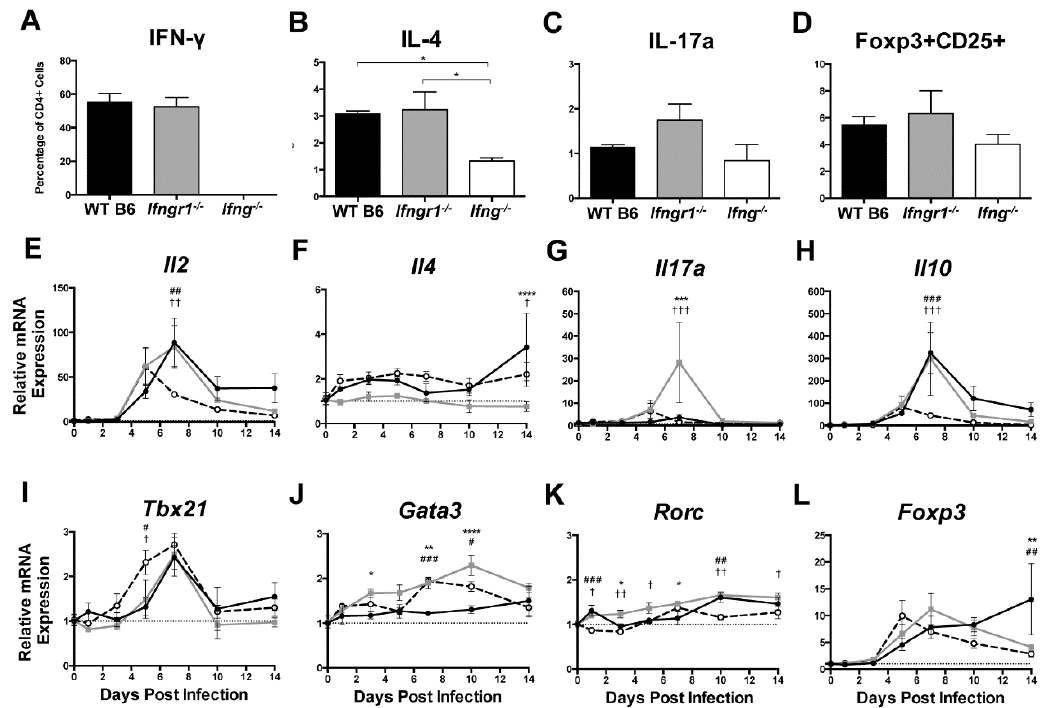
Figure 8. T helper cell profiles in brains of SINV-infected mice with impaired IFN- γ signaling. Flow cytometry was used to examine the percentage of CD4 + T cells producing IFN- γ ( A ), IL-4 ( B ), IL-17a ( C ), or expressing both Foxp3 and CD25 ( D ) in WT (black bars), Ifngr1 − / − (gray bars), and Ifng − / − (white bars) mice at 7 DPI. These markers denoted Th1, Th2, Th17, and Treg cell populations, respectively ( n = 3–7 pooled mice per strain per time point from three independent experiments; data are presented as the mean SEM; * p < 0.05 by Dunn’s multiple comparisons test). ( E – L ) Relative mRNA expression of Il2 ( E ), Il4 ( F ), Il17a ( G ), Il10 ( H ), Tbx21 ( I ), Gata3 ( J ), Rorc ( K ), and Foxp3 ( L ) were examined by qRT-PCR in WT (black circle and solid line), Ifngr1 − / − (gray square and solid line), and Ifng − / − (white circle and black dashed line) mouse brains ( n = 3–4 mice per strain per time point; data are presented as the mean ± SEM; dashed line indicates gene expression of 0 DPI tissue for each strain to which other time points were normalized; * p < 0.05, ** p < 0.01, *** p < 0.001, **** p < 0.0001, WT vs. Ifngr1 − / − ; # p < 0.05, ## p < 0.01, ### p < 0.001, WT vs. Ifng − / − , † p < 0.05, †† p < 0.01, ††† p < 0.001, and Ifngr1 − / − vs. Ifng − / − , all by Tukey’s multiple comparisons test).